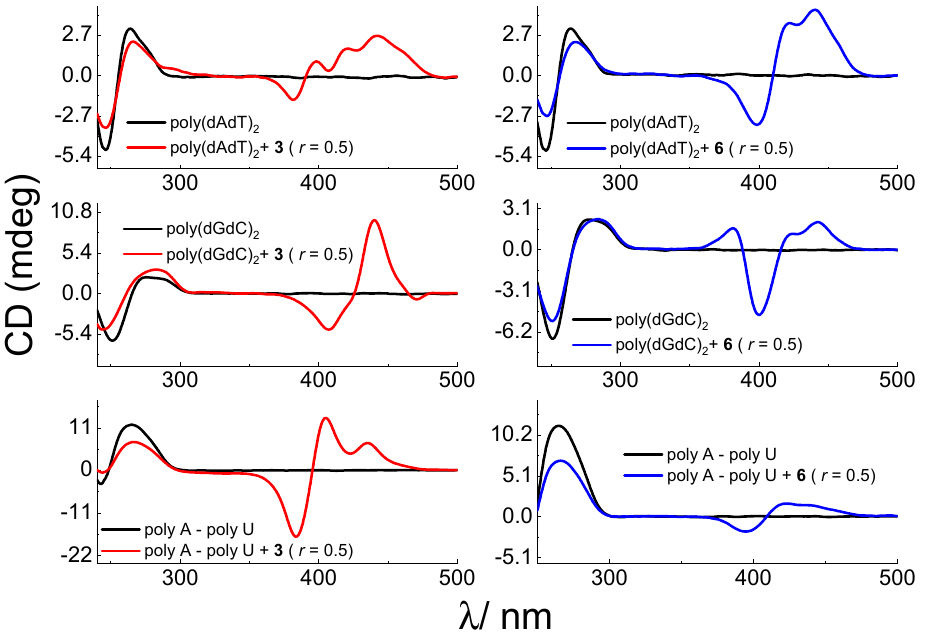
Figure 3. CD spectra of AT- and GC-DNA and AU-RNA ( c = 3.0 × 10 − 5 mol dm − 3 ) with dye 3 and 6 at molar ratios r = [compound]/[nucleotide phosphate] = 0.5 (pH = 7.0, buffer sodium cacodylate, I = 0.05 mol dm − 3 ).